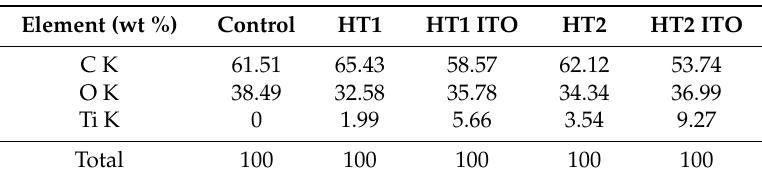
Table 3. Energy-dispersive X-ray spectroscopy (EDX) analysis of polyester fabrics treated with TiO 2 -1% Fe–N photocatalysts.